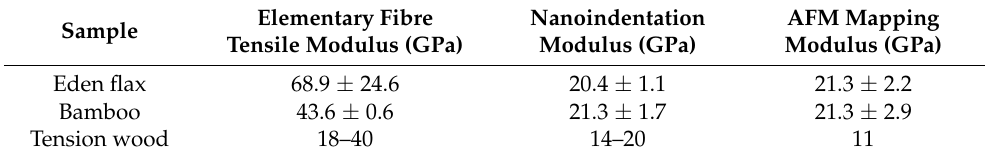
Table 3. Microfibers Young moduli E obtained using different methods for three materials [104].